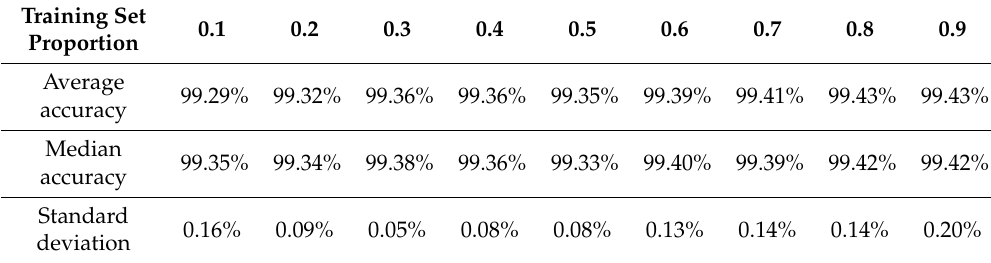
Table 2. Accuracy of di ff erent validation methods on the LFW test set.